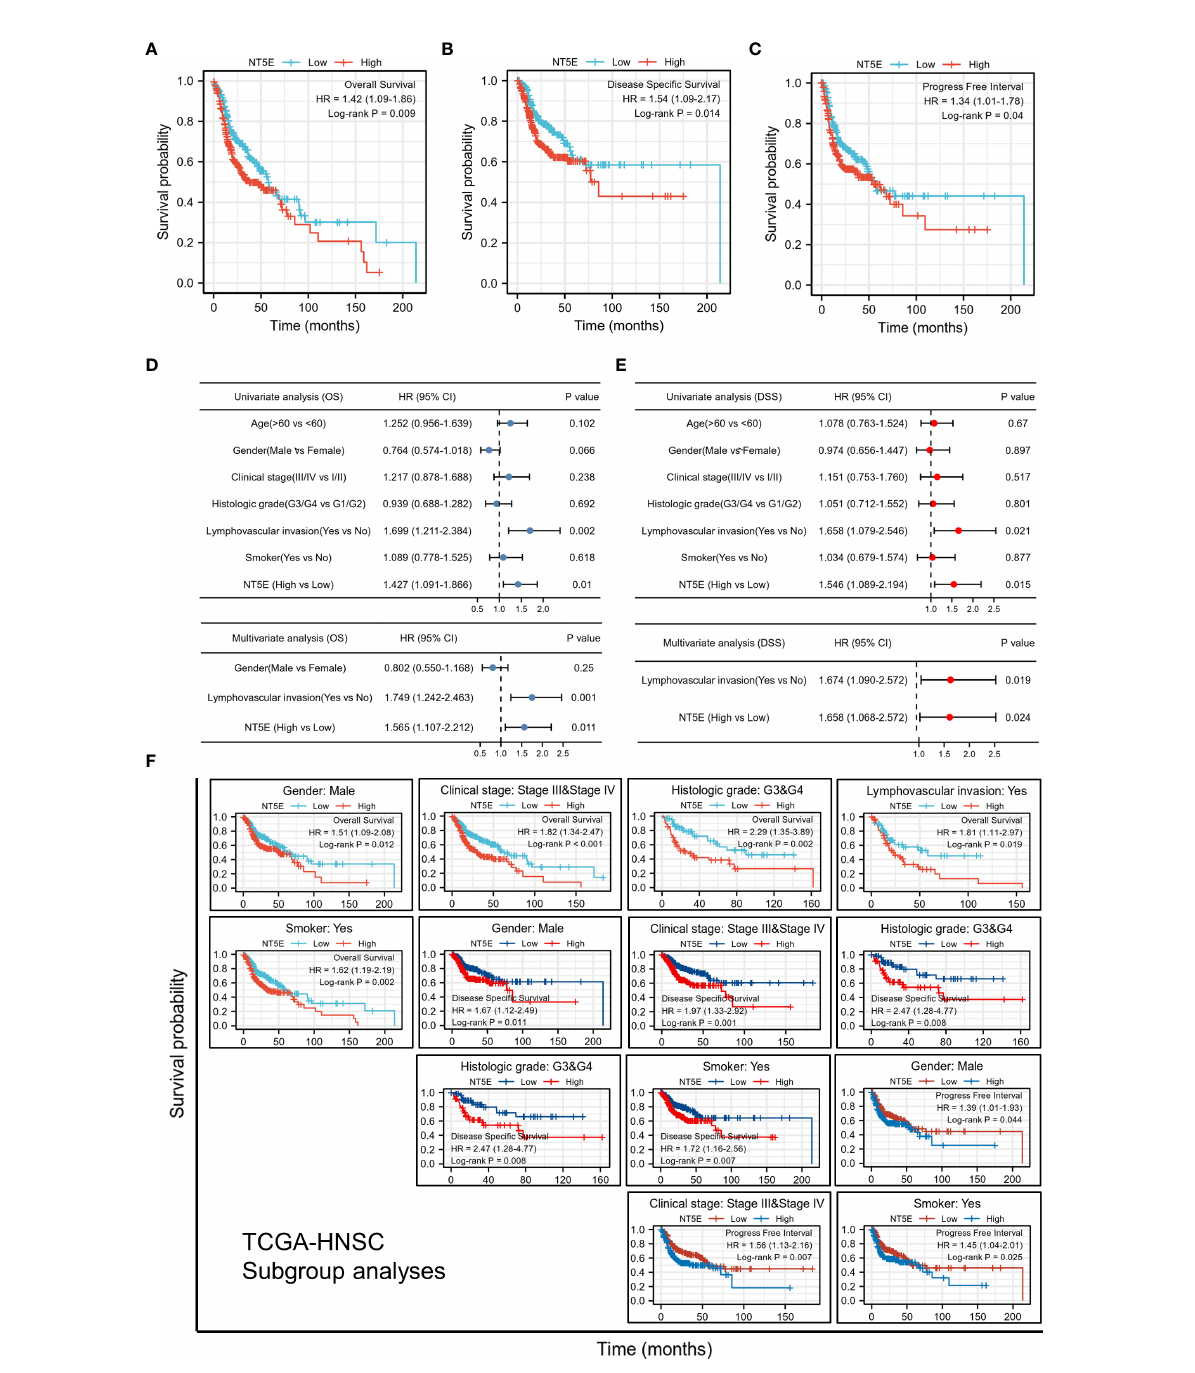
FIGURE 2 Upregulated expression of NT5E indicates poor prognosis in HNSC patients. (A) Patients with high NT5E expression tended to have relatively lower OS (HR=1.42; 95% CI=1.09-1.86; p =0.009). (B) Patients with high NT5E expression tended to have relatively lower DSS (HR=1.54; 95% CI=1.09-2.17; p =0.014). (C) Patients with high NT5E expression tended to have relatively lower PFI (HR=1.34; 95%CI=1.01-1.78; p =0.04). (D) Univariate and multivariate Cox regression analysis of OS (univariate analysis HR=1.427; 95%CI=1.091-1.866; p =0.01 and multivariate analysis HR=1.565; 95%CI=1.107-2.212; p =0.011). (E) Univariate and multivariate Cox regression analysis of DSS (univariate analysis HR=1.546; 95% CI=1.089-2.194; p =0.015 and multivariate analysis HR=1.658; 95%CI=1.068-2.572; p =0.024). (F) Survival analysis of NT5E in different HNSC